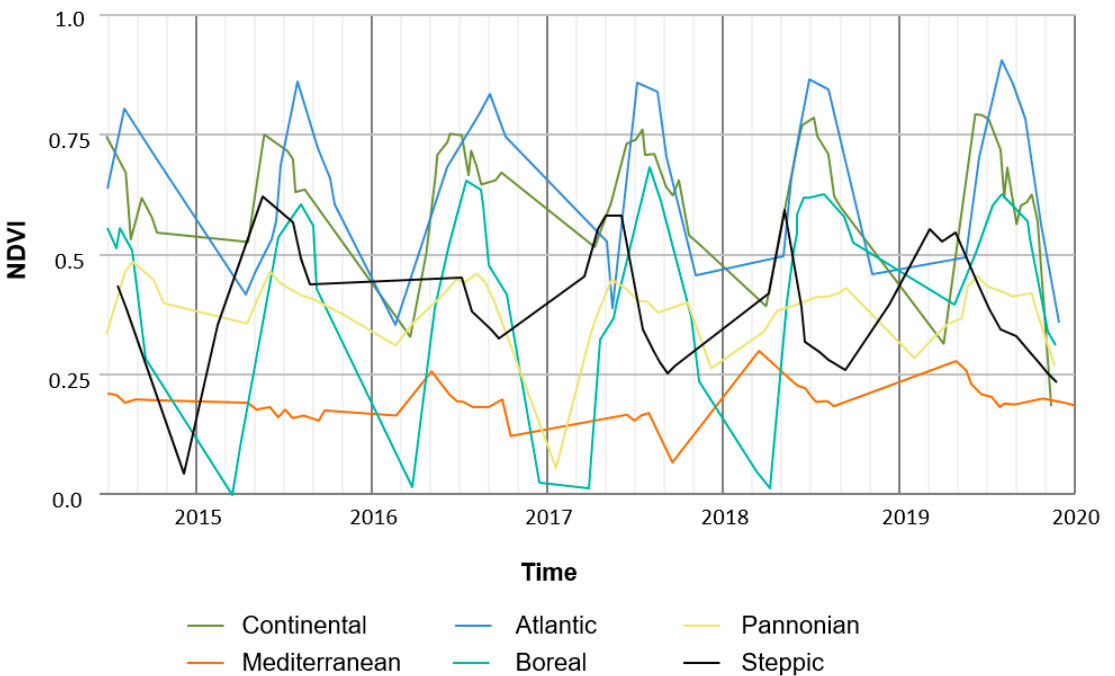
Figure 2. L8 NDVI phenological profiles of underutilized lands in different biogeographical regions.